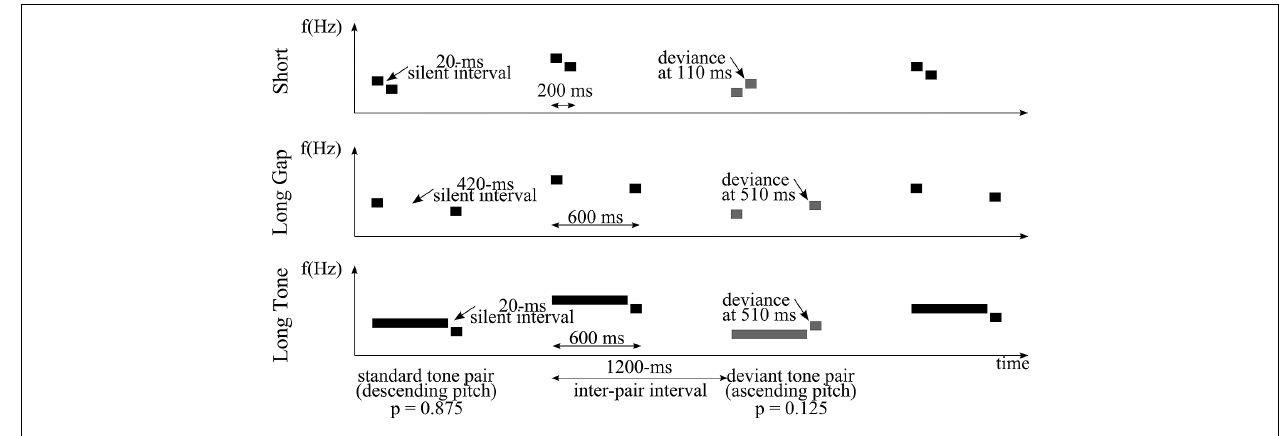
deviant pair (two gray bars) violates the rising rule in that it features a constant ascending pitch relation.To establish an abstract rule, tone pairs varied in their absolute pitch values from trial to trial. Inter-pair interval was 1200 ms.The silent within-pair interval and/or duration of the first tone of a pair varied across